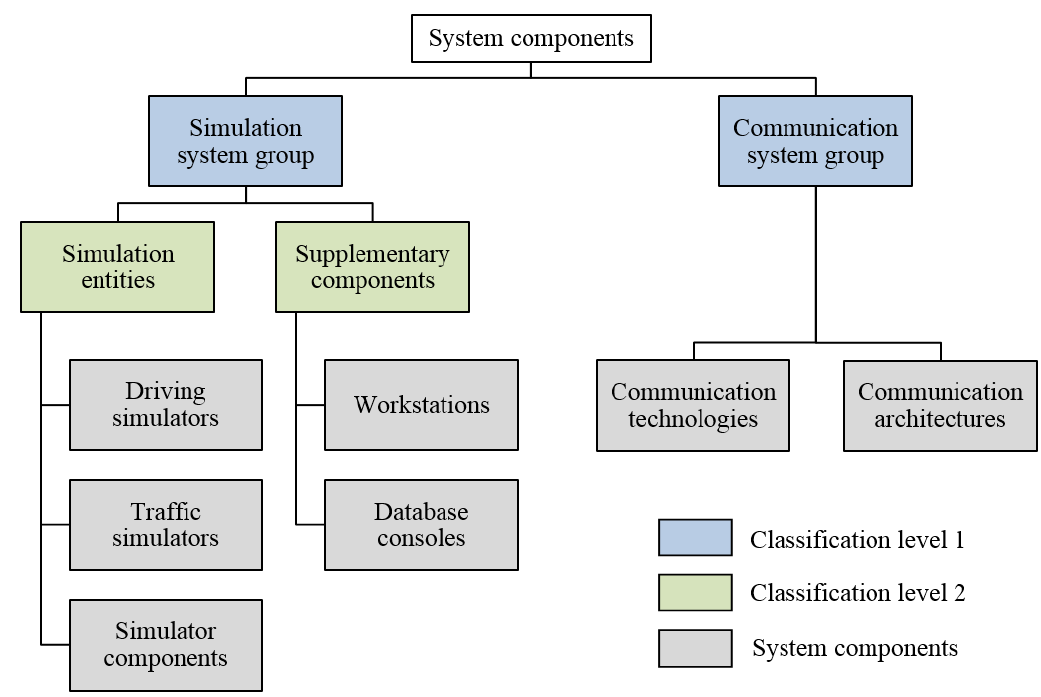
Figure 8. Classification of networked driving simulation system components.